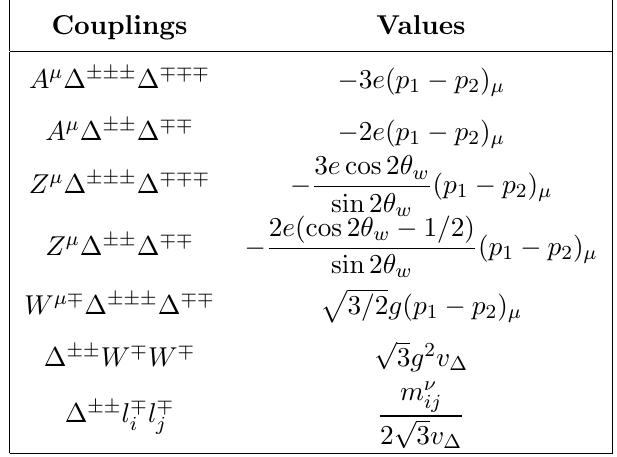
Table 3 . The couplings relevant for production and decay of doubly- and triply- charged scalars.